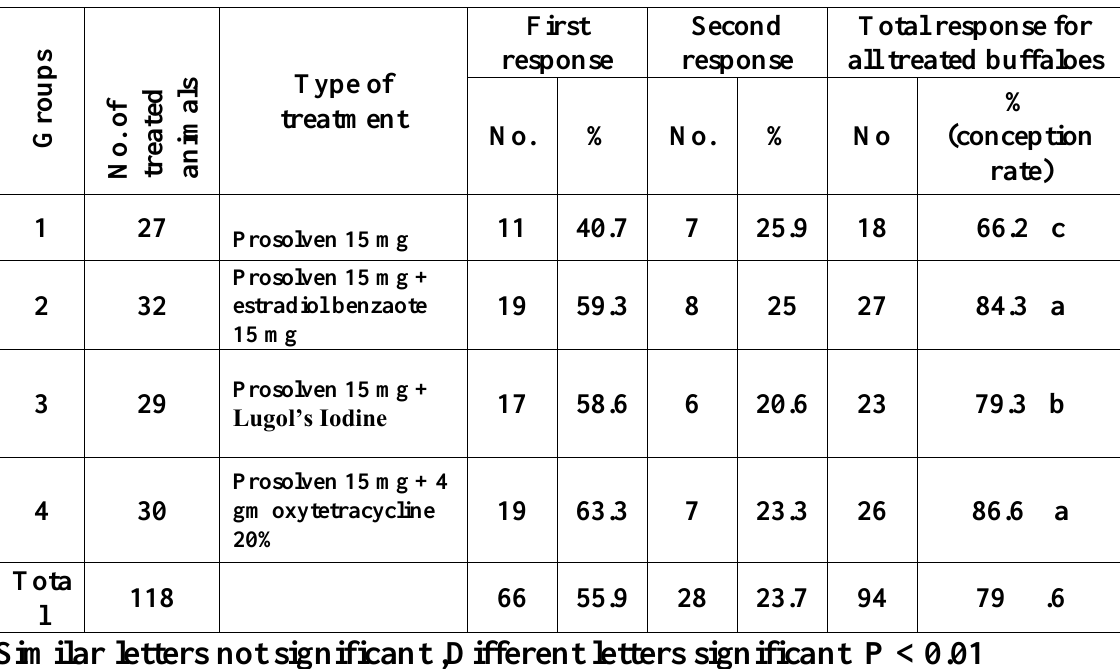
Table 2: Reveals the effect of treatment on reproductive efficency criteria for fertility ,sex and vaibility of new born calves with mean ± SE